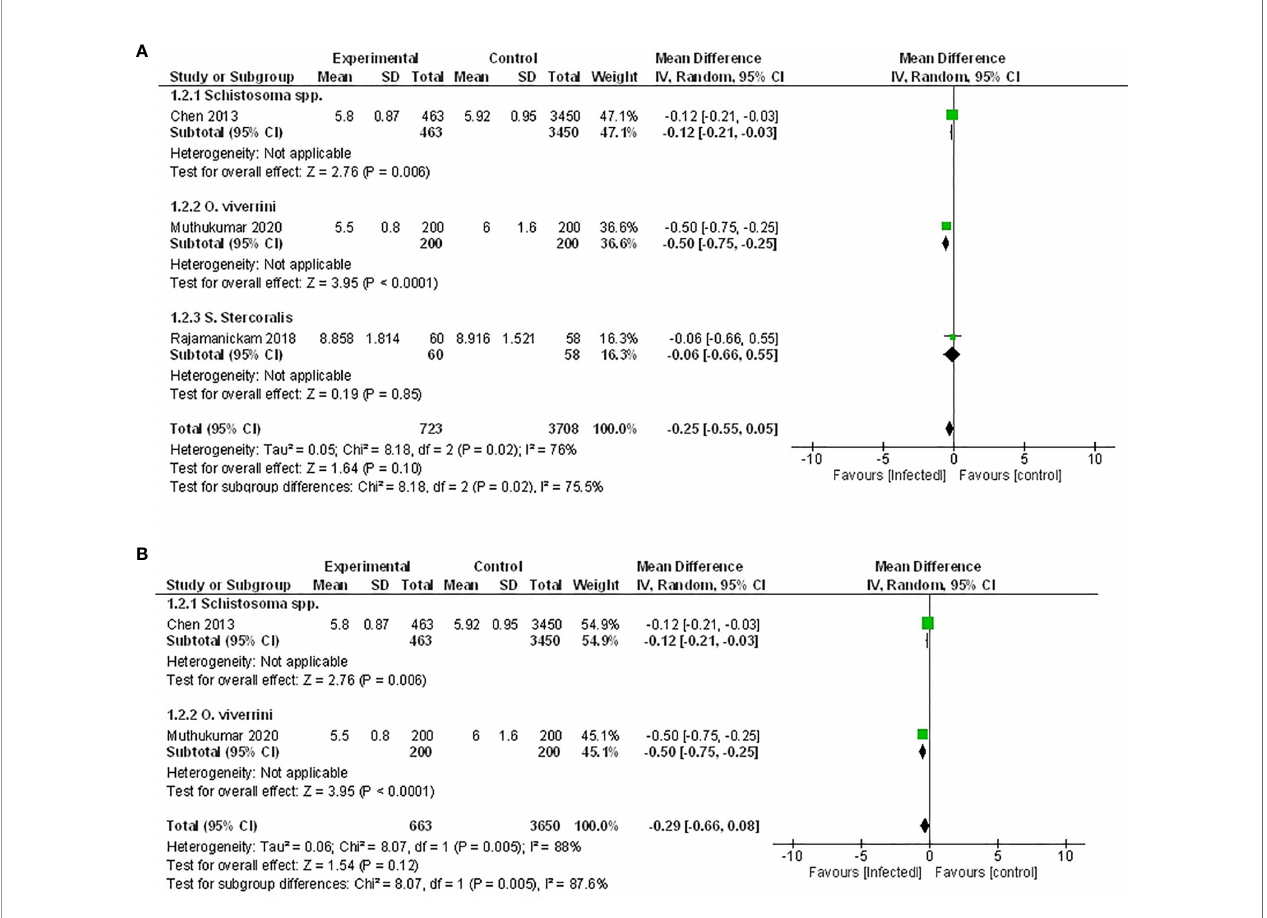
FIGURE 3 | Effect of infection on HbA1c. (A) Forest plot of studies that measured HbA1c. Together, lower HbA1c is favored by infection. (B) Subgroup analysis excluding populations with diabetes only, infection favors lower HbA1c.